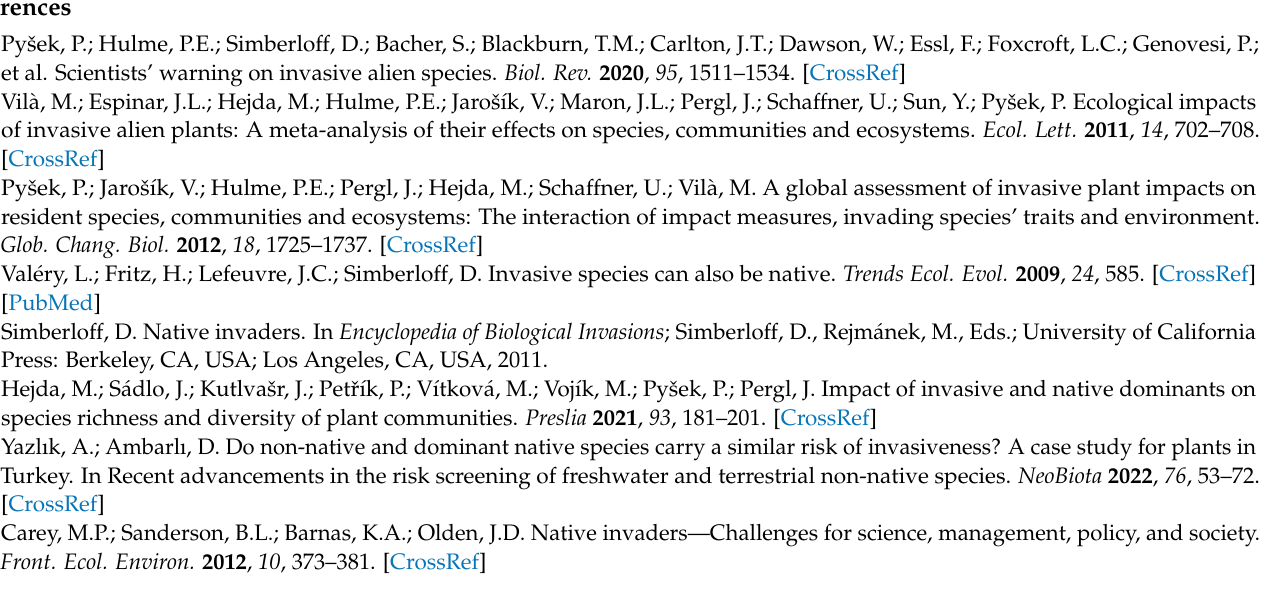
Festuca rupicola in control plots during the mowing regime. Supplementary Materials Figure S6. Species ranks based on their cover between 2001 and 2021 in mown and control plots. Supplementary Materials Figure S7. Temporal change of p -values expressing the probability of the null hypothesis: that species richness in a particular year does not differ between the mown plot and the control